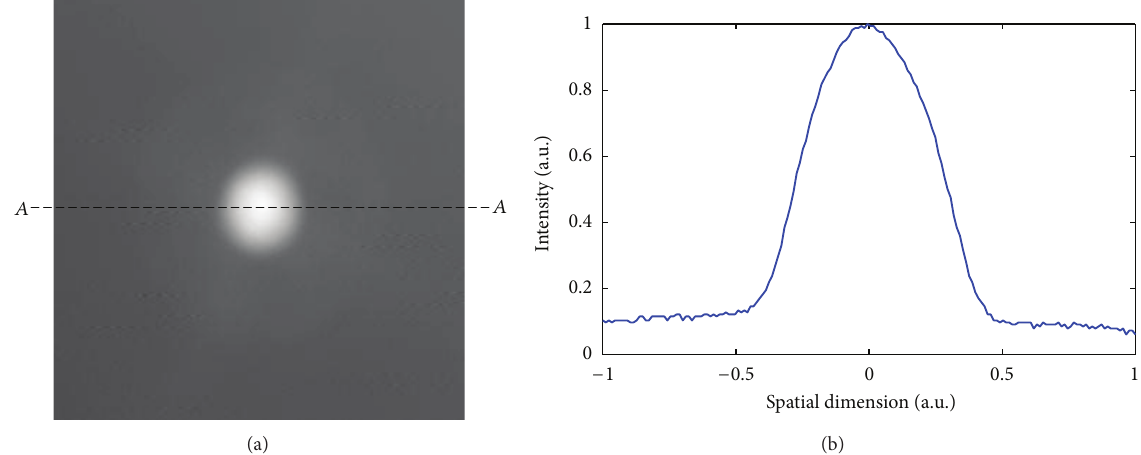
Figure 2: (a) Near-field image of the active fiber end at 1300nm. (b) Intensity profile corresponding to the transversal dashed line 𝐴 - 𝐴 shown in (a).